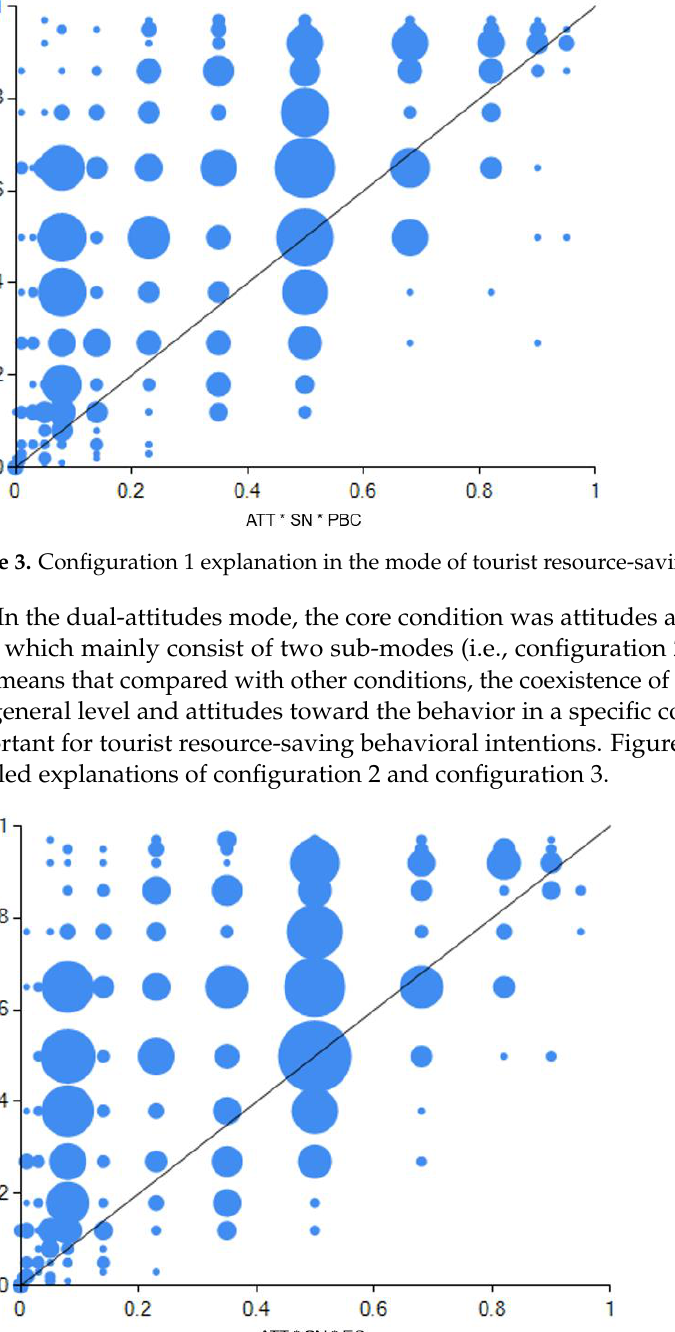
Figure 5. Configuration 3 explanation in the mode of tourist resource-saving behavioral intentions. 4.4.5. Robustness Testing The robustness test was conducted by adjusting the consistency threshold level from 0.8 to 0.85, and no substantial changes were found in the configuration number, configu- ration components, or consistency and coverage’s fitting parameters. The current study’s reliability was enhanced [100].